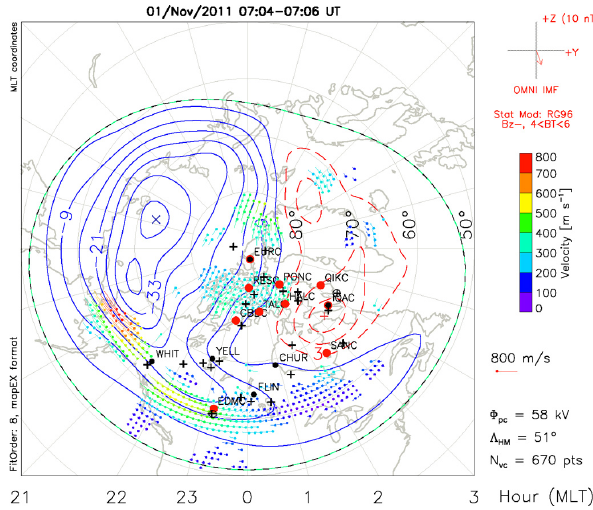
Fig. 12. SuperDARN convection and potential map at 07:04UT showing the SAPS. The CHAIN stations (red dots) and IGS stations (black dots) with IPPs for σ 8 > 0 . 1 radians (open circles) and/or DPR > 2mms − 1 (crosses) are